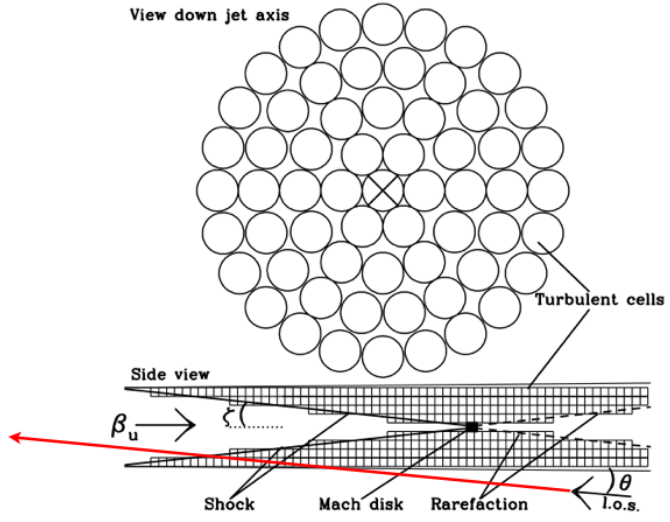
Figure 1. A schematic representation of the Turbulent Extreme Multi-Zone (TEMZ) model—reproduced from [3]. The radio core of a blazar is modeled as a collection of thousands of turbulent cells of plasma moving relativistically across a standing shock. The red line depicts how, along a given sight-line through the TEMZ grid, an individual ray will pierce multiple cells of plasma, each with distinct magnetic field